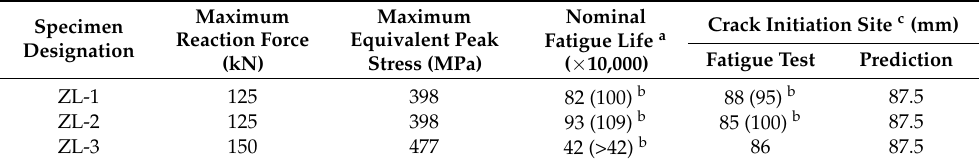
Table 4. Fatigue test results of the variable-section supports with right-angle end